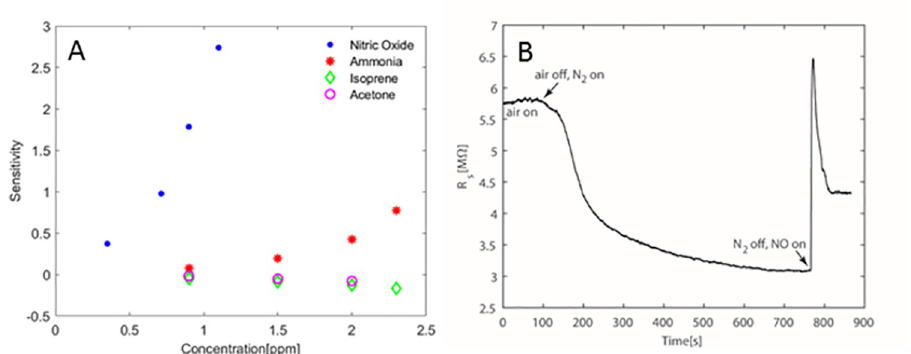
Fig 1. Breathalyzer sensitivity for NO. A. To demonstrate sensitivity to NO, known concentrations of NO, ammonia, isoprene, and acetone were put into breath bag and “exhaled” over circuit. The circuit showed excellent sensitivity to NO and minimal interaction with ammonia at higher concentrations and no signal from acetone and isoprene. B. Specificity of circuit for NO versus N 2 demonstrates that circuit does not interact with N 2 , but has robust detection of